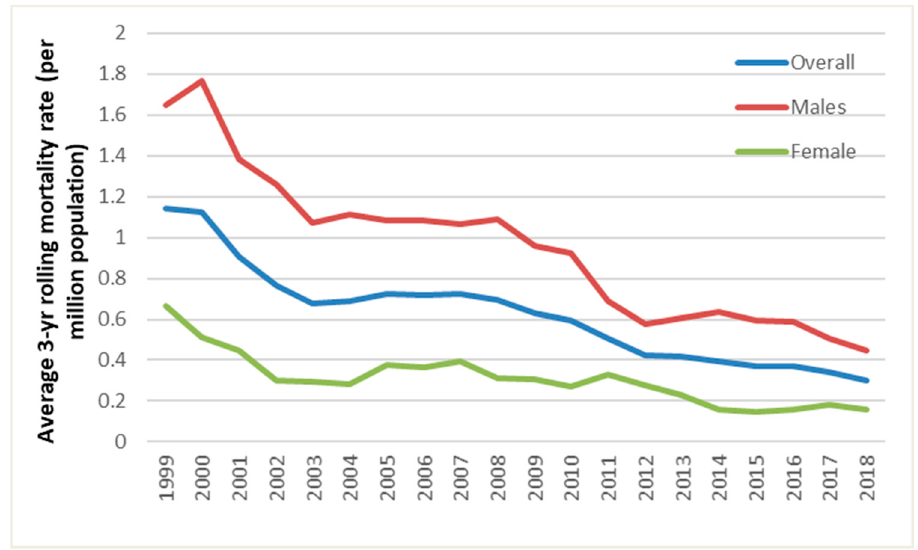
Figure 2. The average 3 ‐ year rolling mortality rate of fatal UNFR CO poisoning in England and Wales by sex and year, 1999 to 2018.